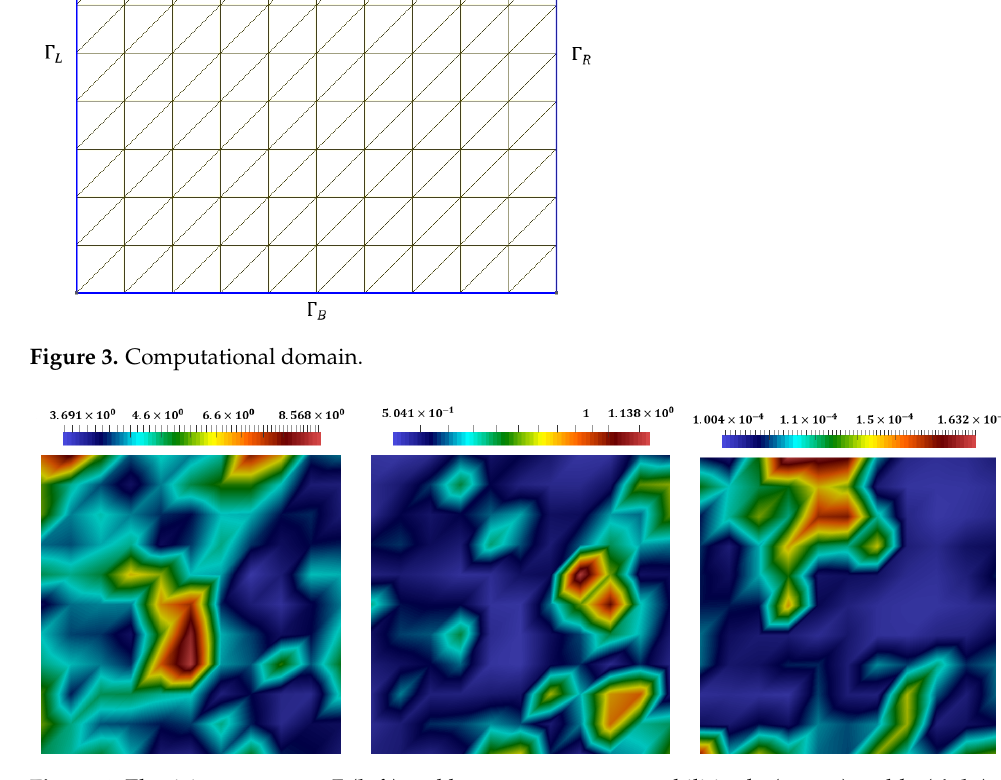
Figure 4. Elasticity parameter E ( left ) and heterogeneous permeabilities k 1 ( center ) and k 2 ( right